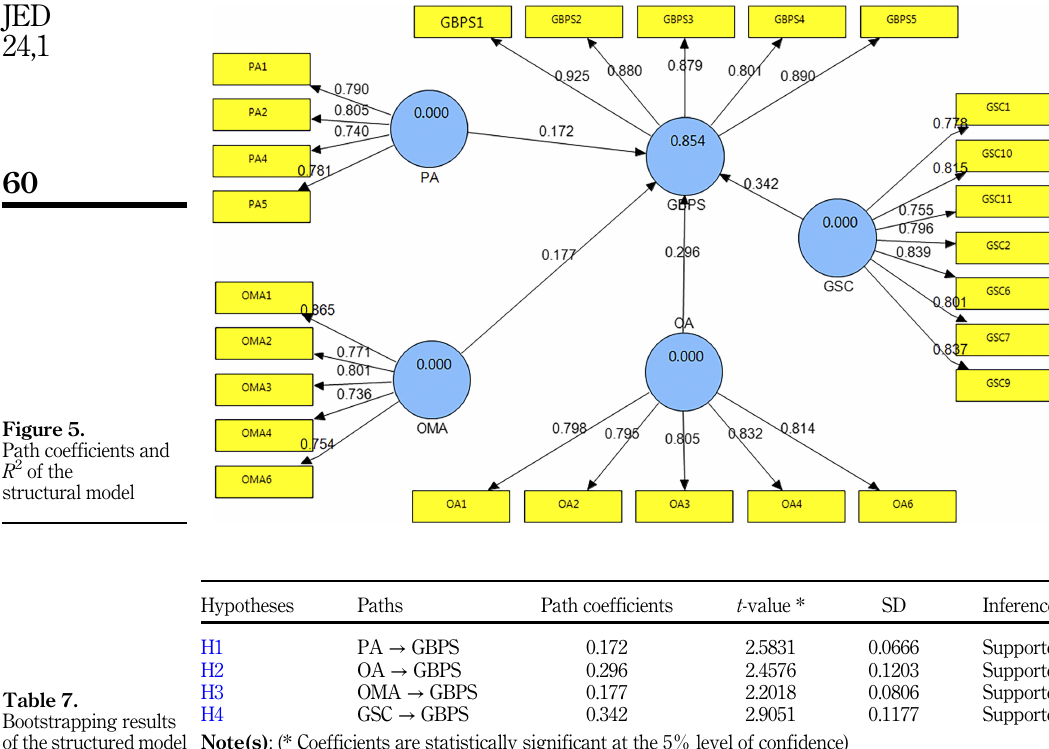
Figure 5. Path coefficients and R 2 of the structural model